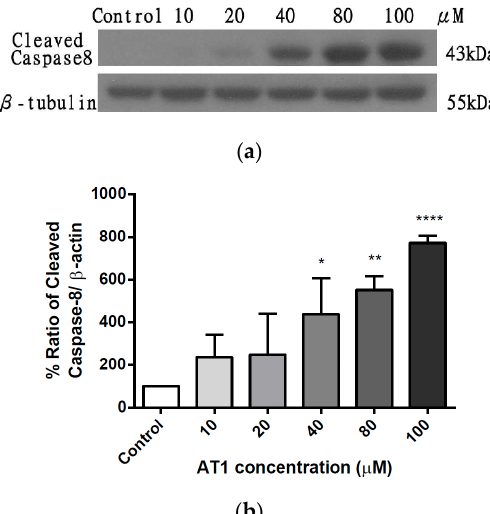
Figure 7. The effects of various concentrations of AT-I on the expression levels of cleaved caspase 8 was assessed by western blotting, after cells were treated with AT-I for 48 h. The control group was not treated with AT-I. Total protein concentration of each sample was determined and normalized.